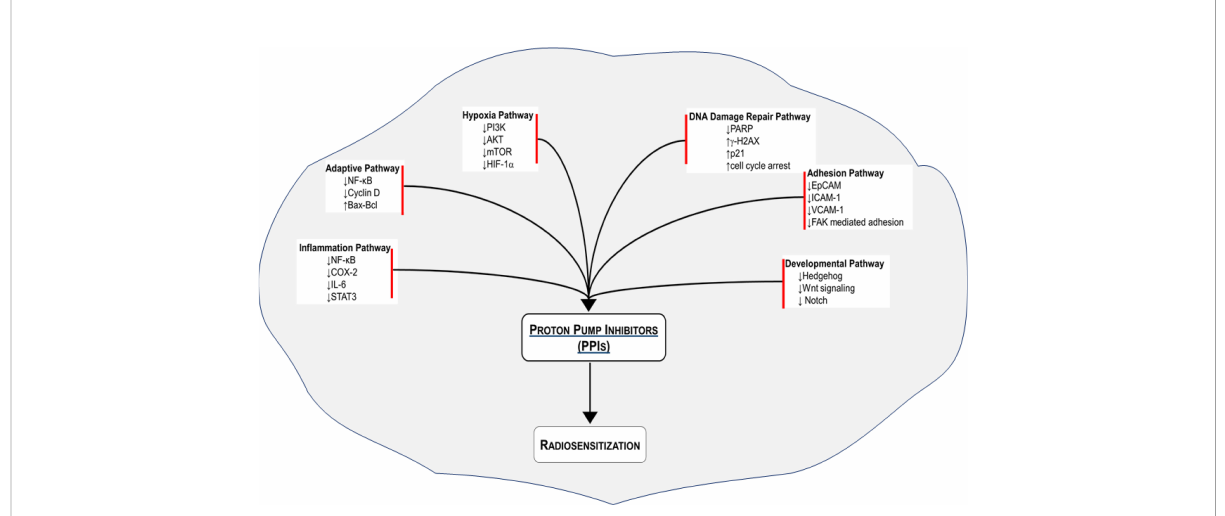
FIGURE 1 Radiosensitization of cancer cells with proton pump inhibitors (PPIs). Several radioresistance-related signaling pathways are regulated by PPIs to improve the response of various cancer cell types to radiation